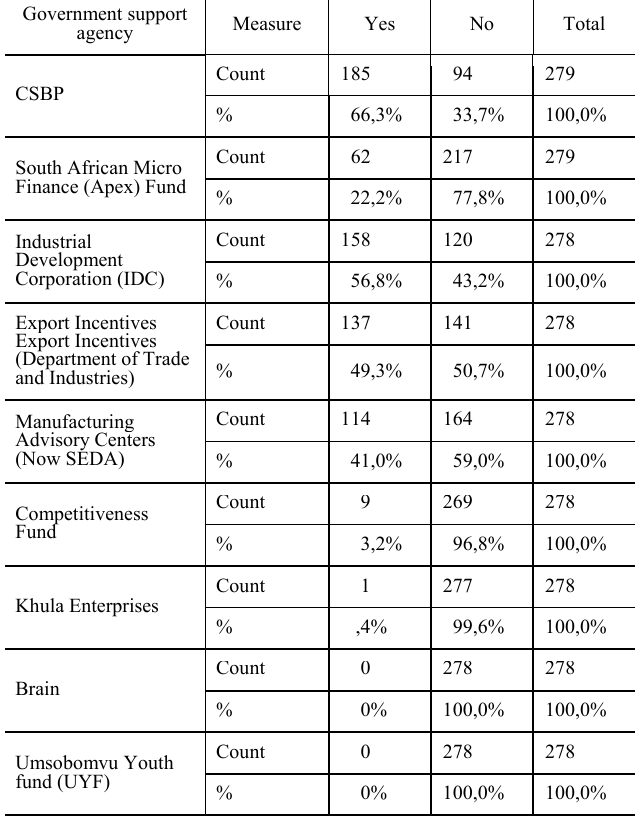
Table 8: Opinions on government support services